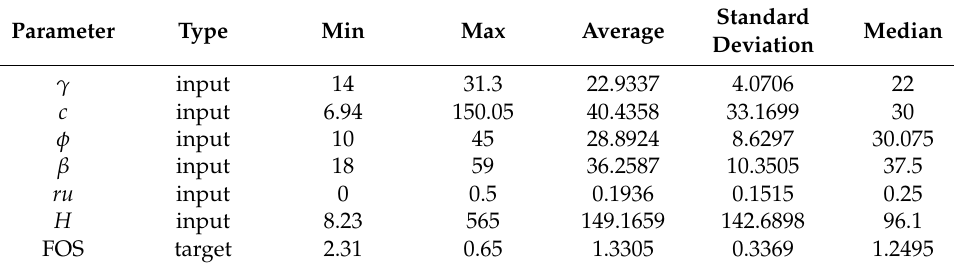
Table 4. The main statistical information of the dataset.